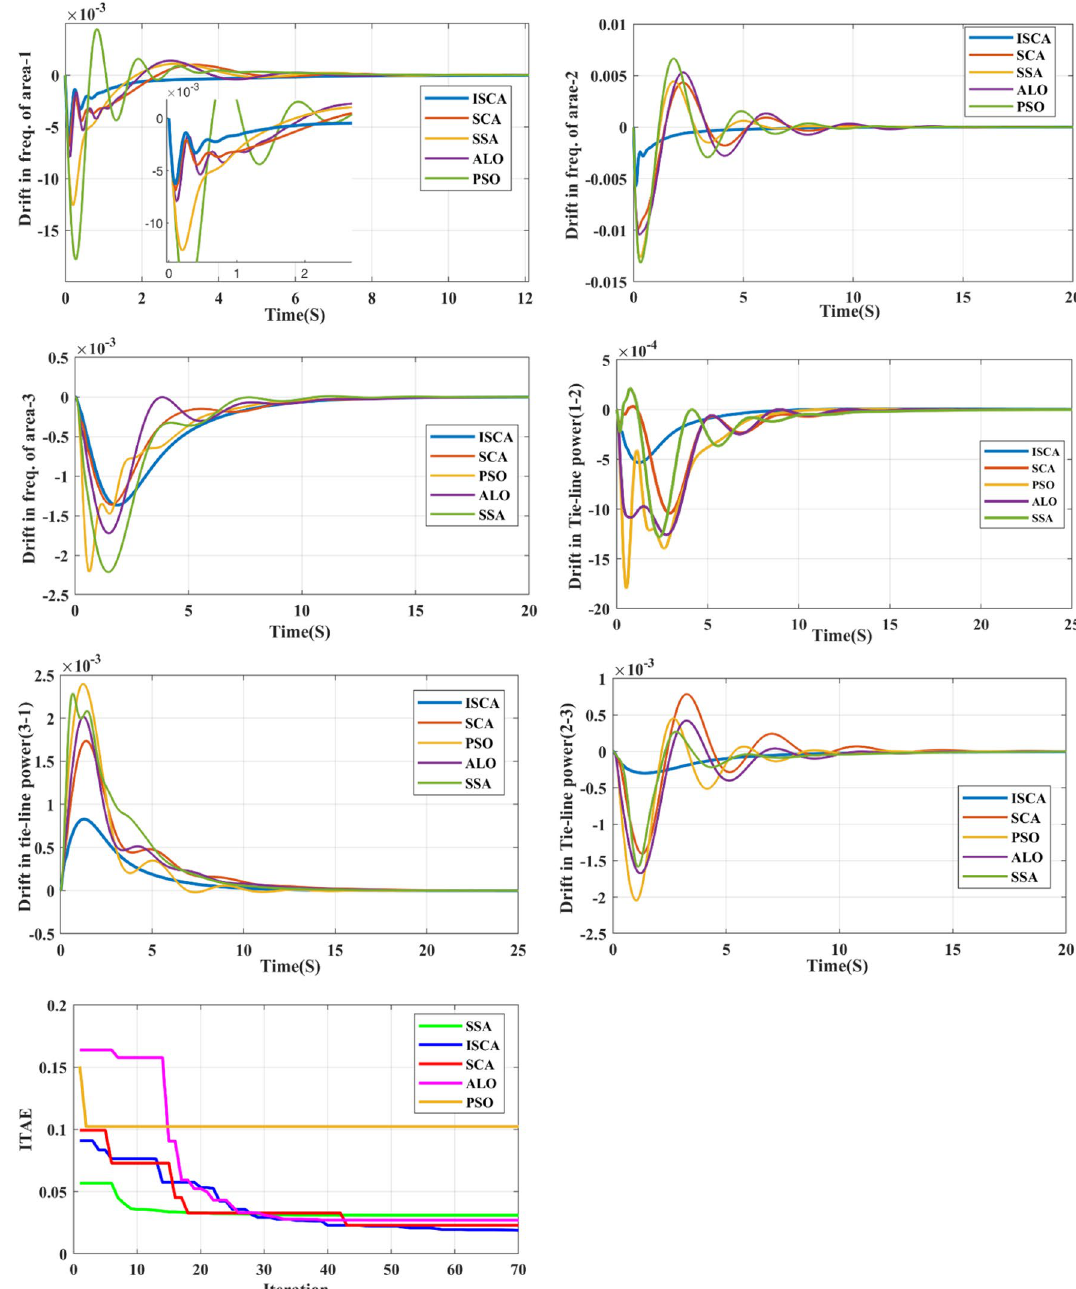
Fig. 5 Transient responses of frequency and tie-line power of all areas and convergence curves of the various algorithms for SLD of 2% in area-1 and area-2 with the proposed and other existing